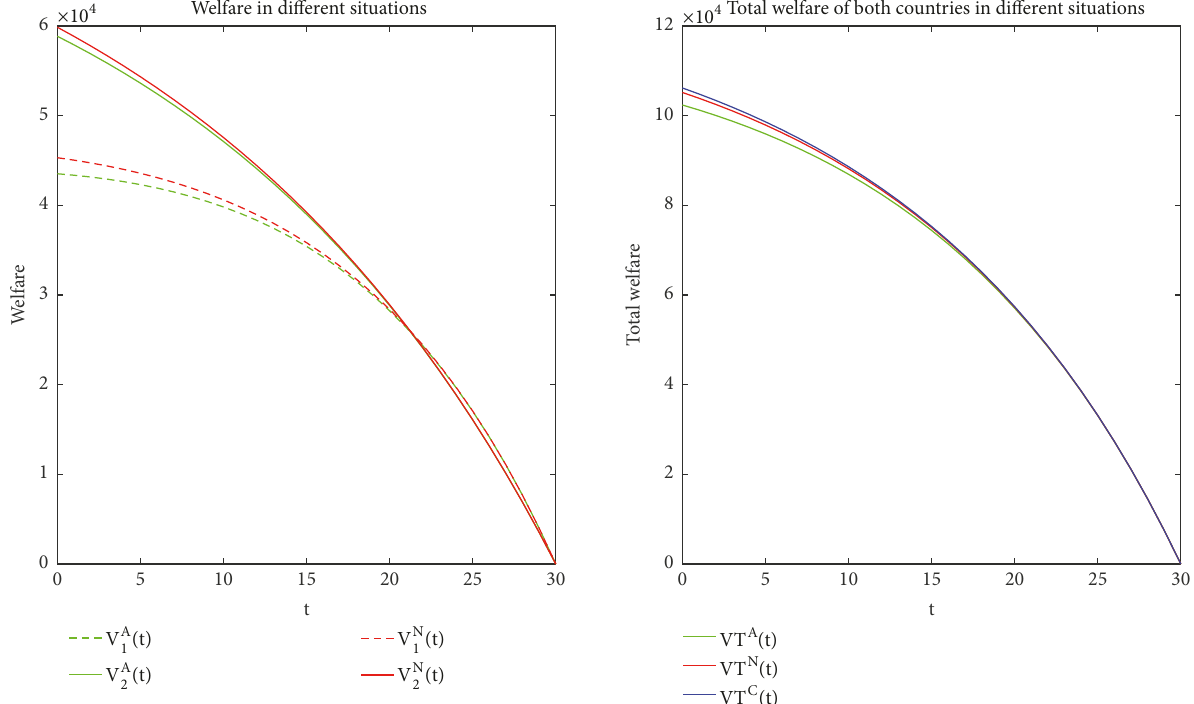
Figure 3: The welfare in the case